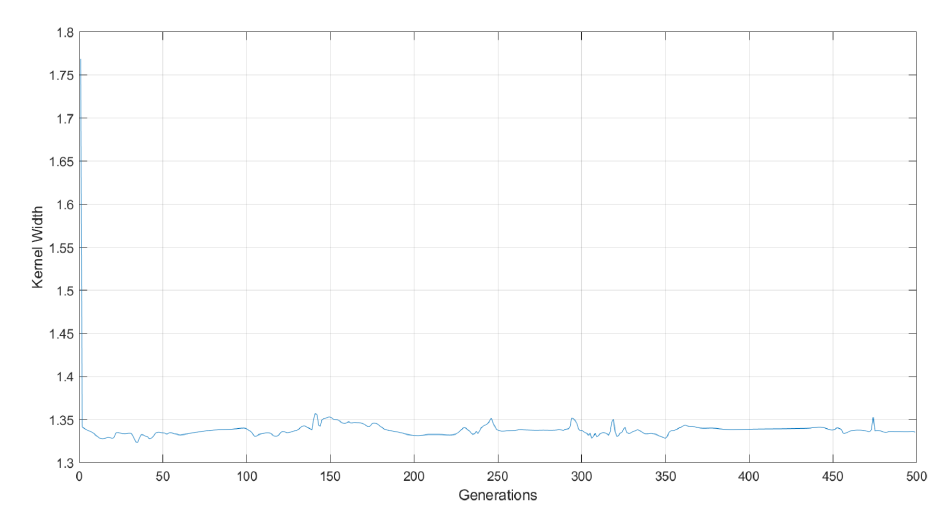
Figure 8. Kernel width variation during